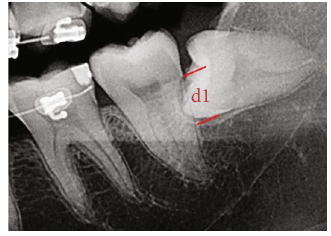
Figure 1: Preoperative data measurements (d1).